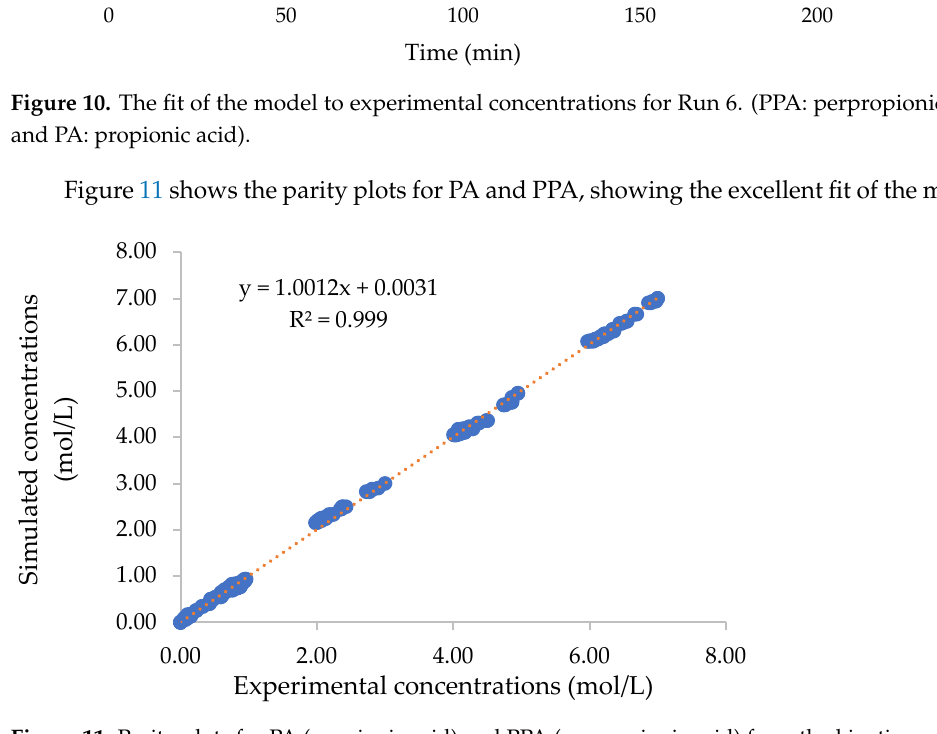
Figure 11. Parity plots for PA (propionic acid) and PPA (perpropionic acid) from the kinetic model of propionic acid perhydrolysis over amberlite IR ‐ 120.